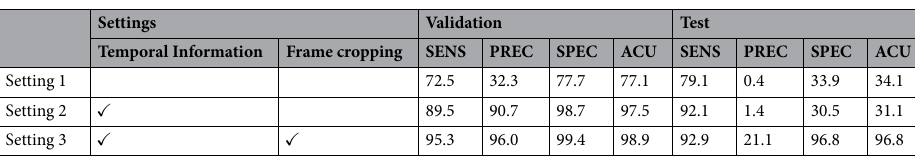
Table 5. Performance of different algorithm designs in header